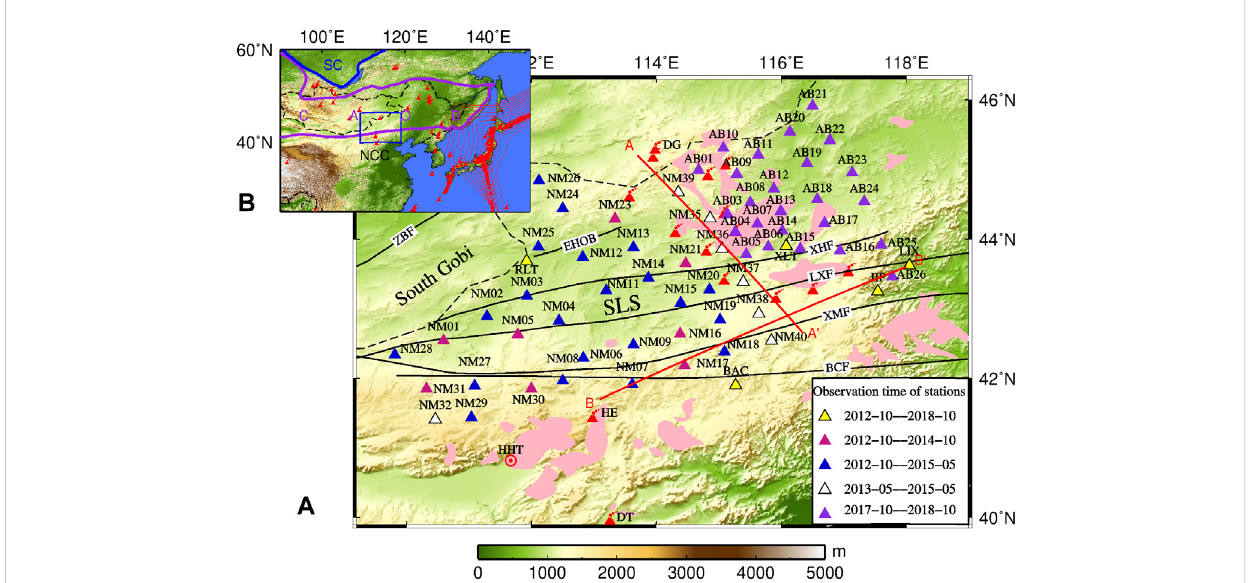
FIGURE 1 Topographic map of the study area showing seismic stations used in the study. (A) Purplish red, blue and white triangles respectively represent the temporary seismic station location of NM Array, while lotus triangle represents the temporary seismic station location of AB Array, yellow triangle represents the permanent fi xed station position of China Seismological Bureau. Pink area denotes the distribution of the cenozoic basalts (Guo et al., 2016) and active faults (Xiao et al., 2003; Xu et al., 2013) are represented by black solid lines. The red triangle is the location of the volcano, in which DG is the Dariganga volcano, HE is the Honggeertu volcano, DT is the Datong volcano, and the rest is the Abaga volcano group. (B) The study area on a large scale, in which the blue solid rectangle outlines the study area. Abbreviations on the map are as follows: SLS, Solonker Suture; EHOB, Erenhot HegenshanOphioliteBelt;ZBF,ZuunbayanFault;XHF,XilinhotFault;LXF,LinxiFault;XMF,XilamulunFault;BCF,BayanObo-ChifengFault;HHT,Hohhot; SC, Siberian Craton; CAOB, Central Asia Orogenic Belt; NCC, North China